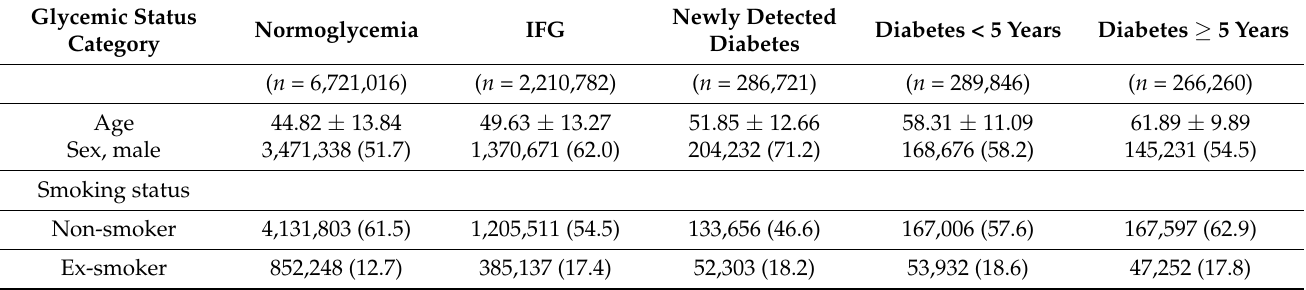
Table 1. Baseline characteristics of the study